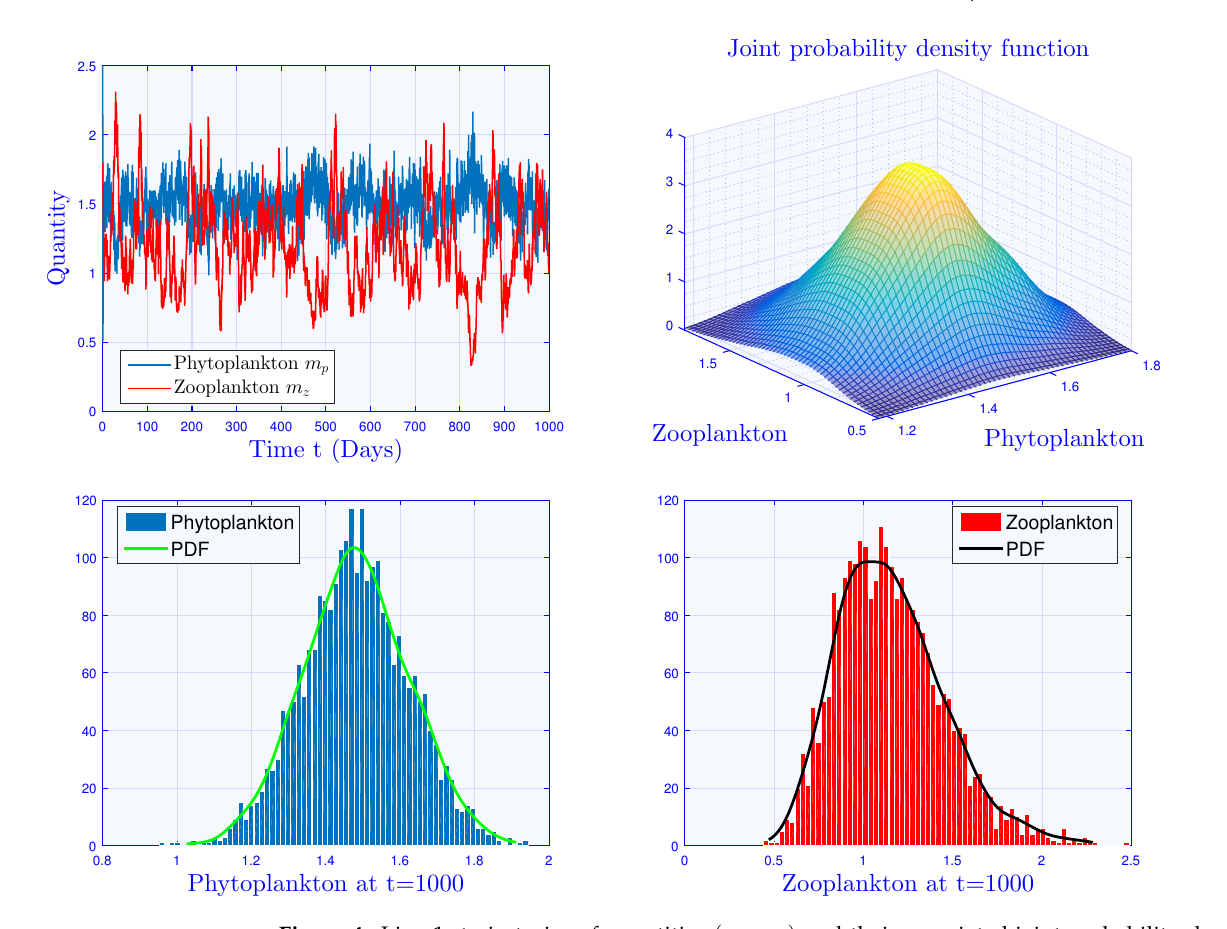
food chain. In Figure 4, we depict the permanence phenomenon by drawing trajectories and sketching the experimental two-dimensional density of ( m p , m z ) .